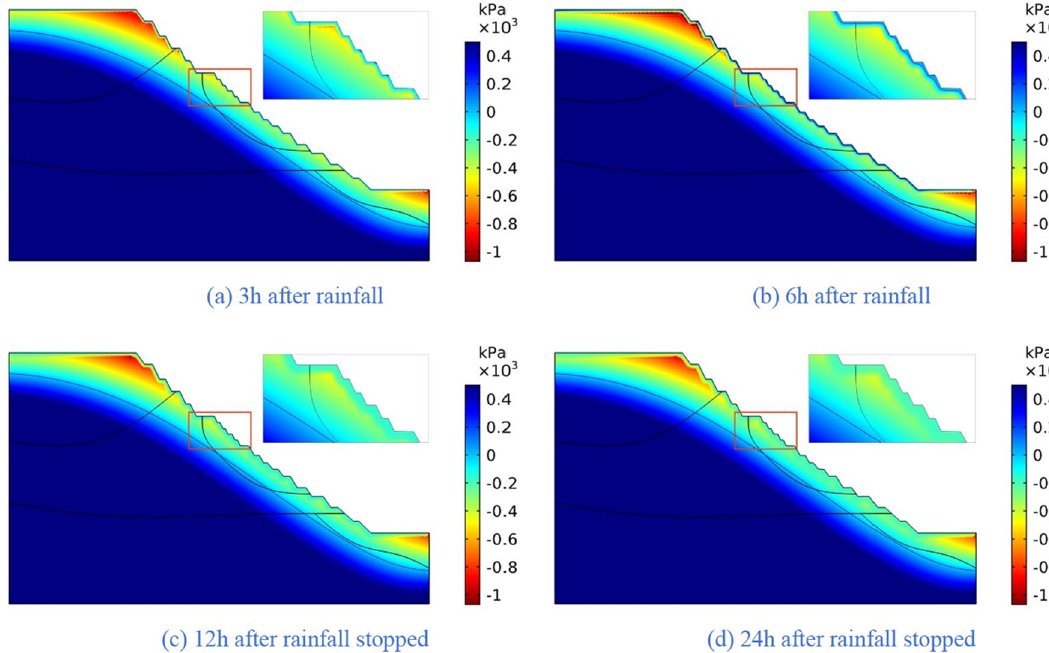
Figure 21. The pore-water pressure distribution (Scheme IV).